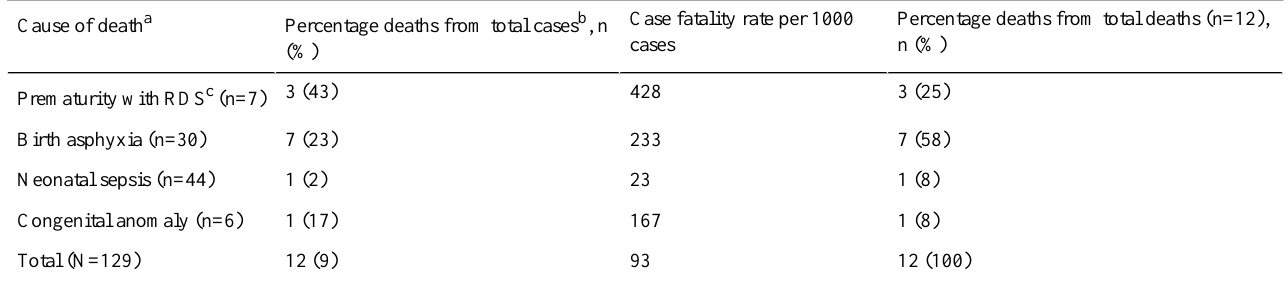
Table 4. Cause of death and case fatality rates.